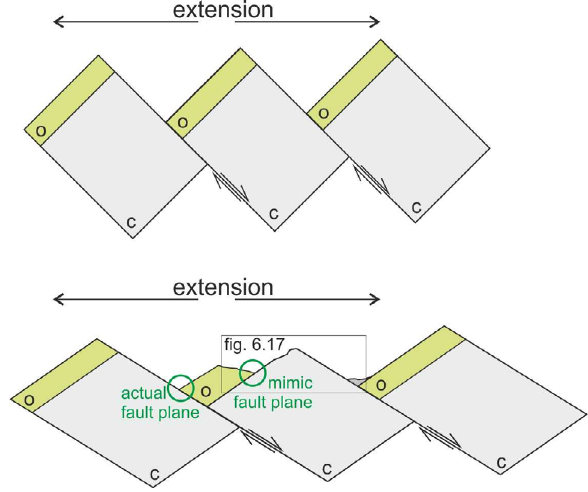
Figure 6. Concept of fault scarp evolution at the Piskupat fault. o=ophiolite, c=carbonate. Planar rotational faults evolve under an extensional stress regime. Later these are subject to erosion. As the erosion strips off the ophiolites from the underlying carbonates the shape of the fault can evolve. The halfgraben below the fault is filled with debris from the